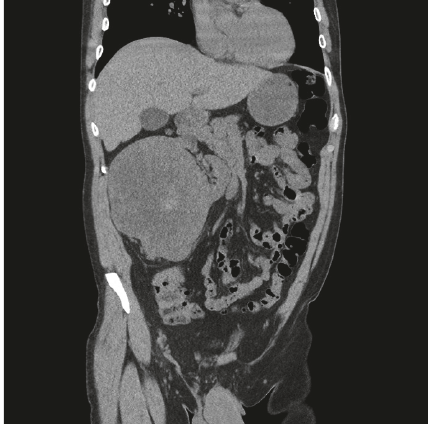
Figure 2: Computed tomography without contrast demonstrating a large heterogeneous right renal mass.